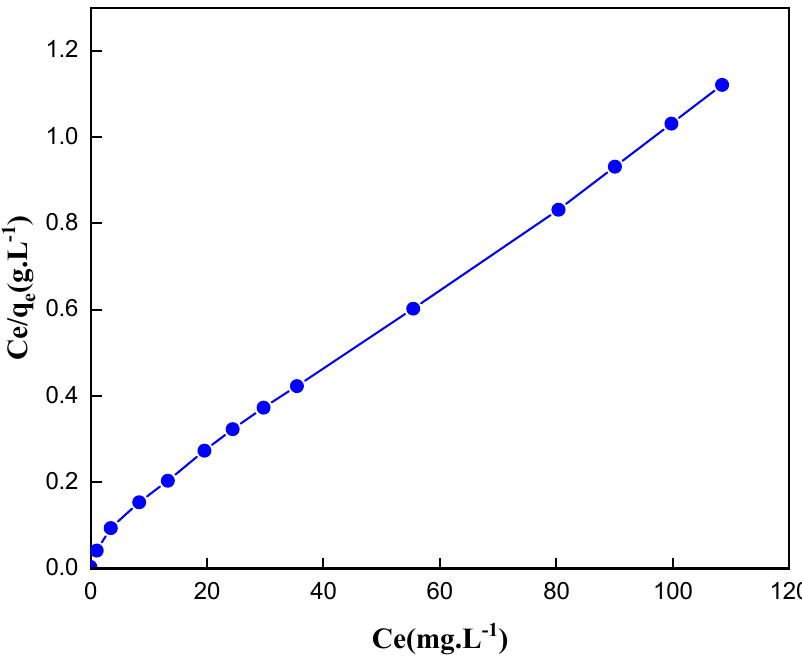
Figure 9. Langmuir adsorption model fit of Cu(II) on SiN-imd-py . Table 4. Parameters for the Langmuir, Freundlich, Dubini–Radushkevich and Temkin of Cu(II) ad- sorption.